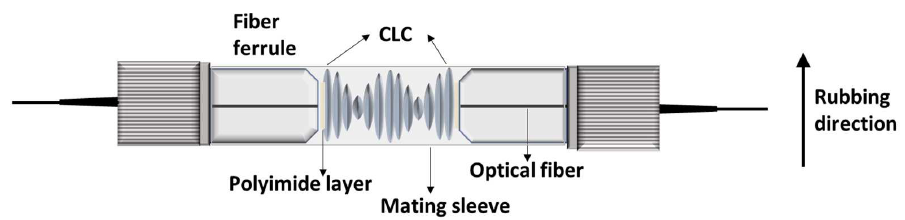
Figure 2. Fabrication process of the CLC cell.